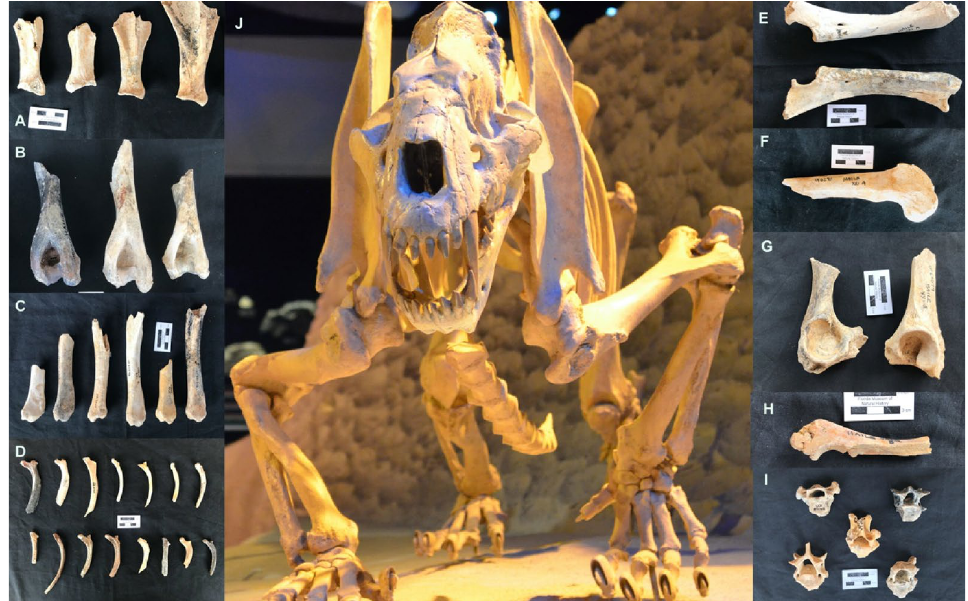
Figure 1. Examples of the carcass consumption capabilities of Xenosmilus . Complete defleshing and frequent contact with bone resulting in bone breakage and deletion has been documented on scapulae ( A ), humeri ( B ), tibiae ( C ), ribs ( D ), femora ( F ), innominates ( G ), ulnae ( E, H ), and vertebrae ( I ), with a many of the latter completely fragmented. In contrast, radii appear less affected ( E ), as in carcasses consumed by modern lions (Fig. 2). A complete skeleton of Xenosmilus hodsonae is shown in the center, resulting from the combination of the fairly complete holotype skeleton and the paratype skeleton found together at Haile 21A ( J ). This mounted skeleton is currently displayed at the Florida Museum of Natural History